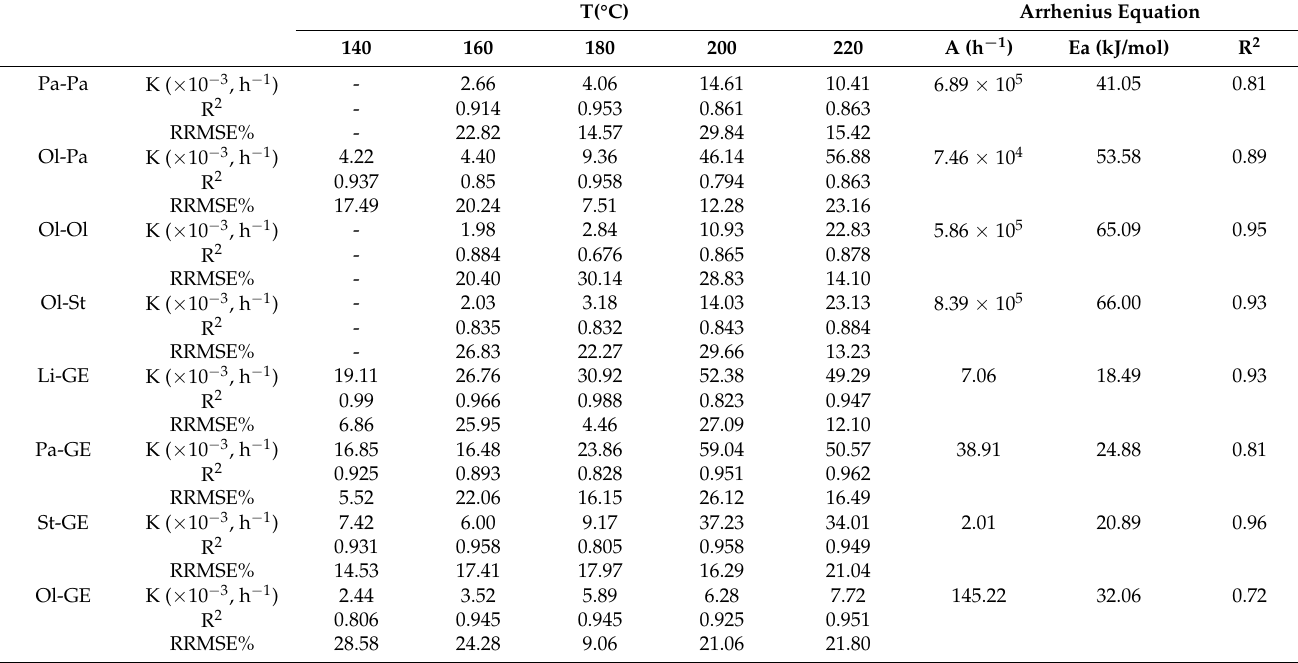
Table 3. Kinetic parameters of 3-MCPDE formation and GE degradation at various temperatures (140 − 220 ◦ C) in palm oil during frying chicken